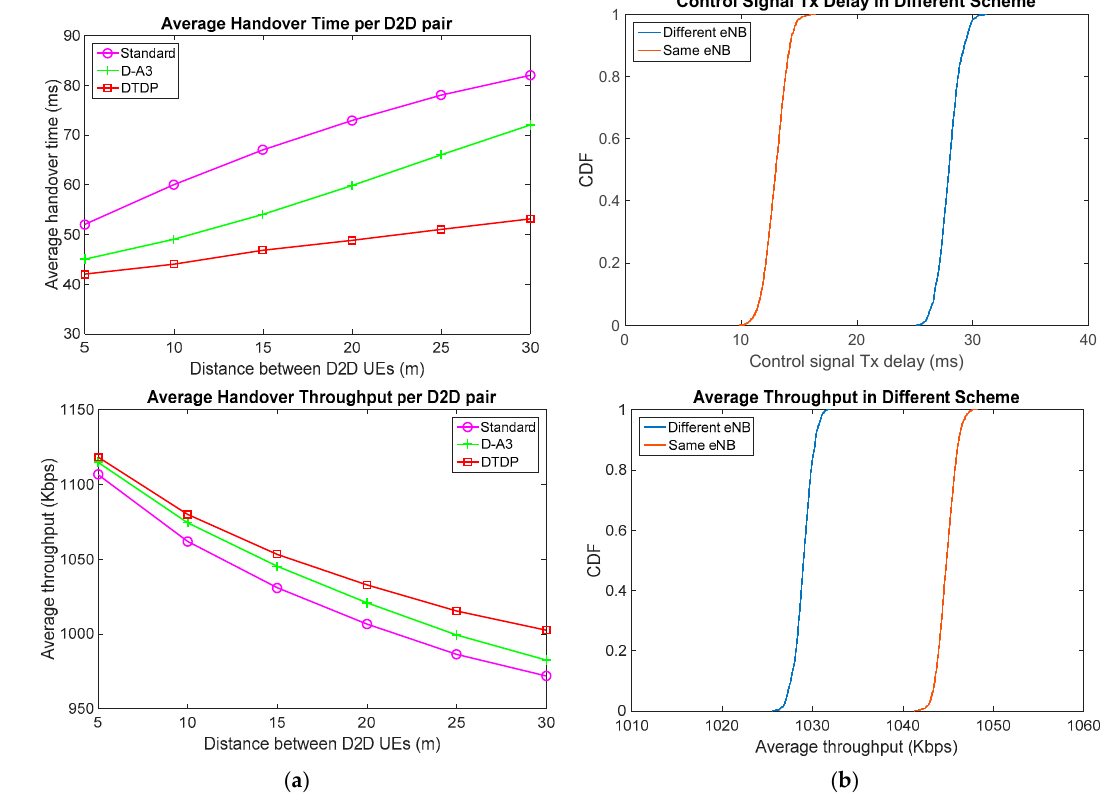
Figure 6. Average handover time and average throughput versus the distance between two device-to-device user equipment (DUEs) of the same pair, and the cumulative distribution function (CDF) analysis of transmission delay and average throughput of the system. ( a ) Performance of average handover time and average throughput. ( b ) CDF of transmission delay and average throughput.